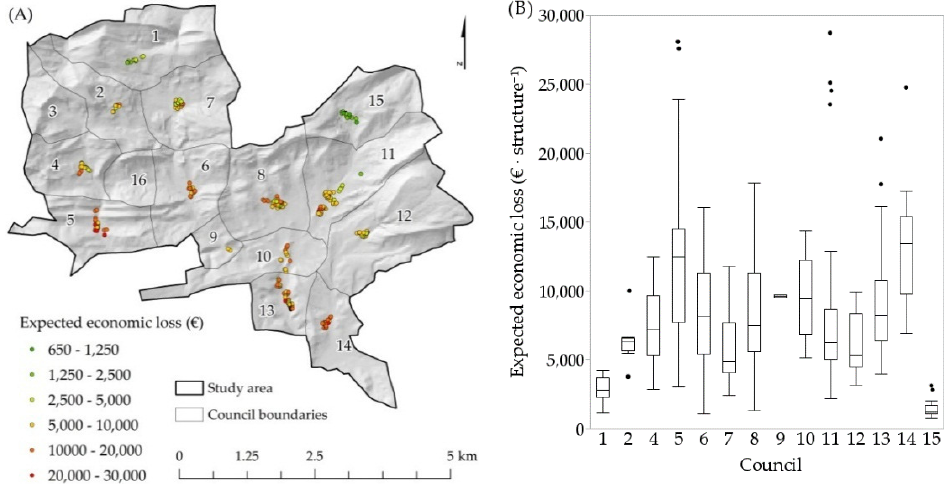
Figure 12. Map ( A ) and box ‐ plots ( B ) of expected economic losses (eEL) for residential houses given that a fire occurs within the fire modeling domain under extreme fire weather conditions. Councils No. 3 and No. 16 do not have residential houses. In the map, every dot corresponds to a single residential house. In the boxplots, boxes indicate the first/third quartiles, the whiskers indicate 10th/90th percentiles, the black line within the box is the median, and the dots indicate values below the 10th percentile or above the 90th percentile (€ structure − 1 ).